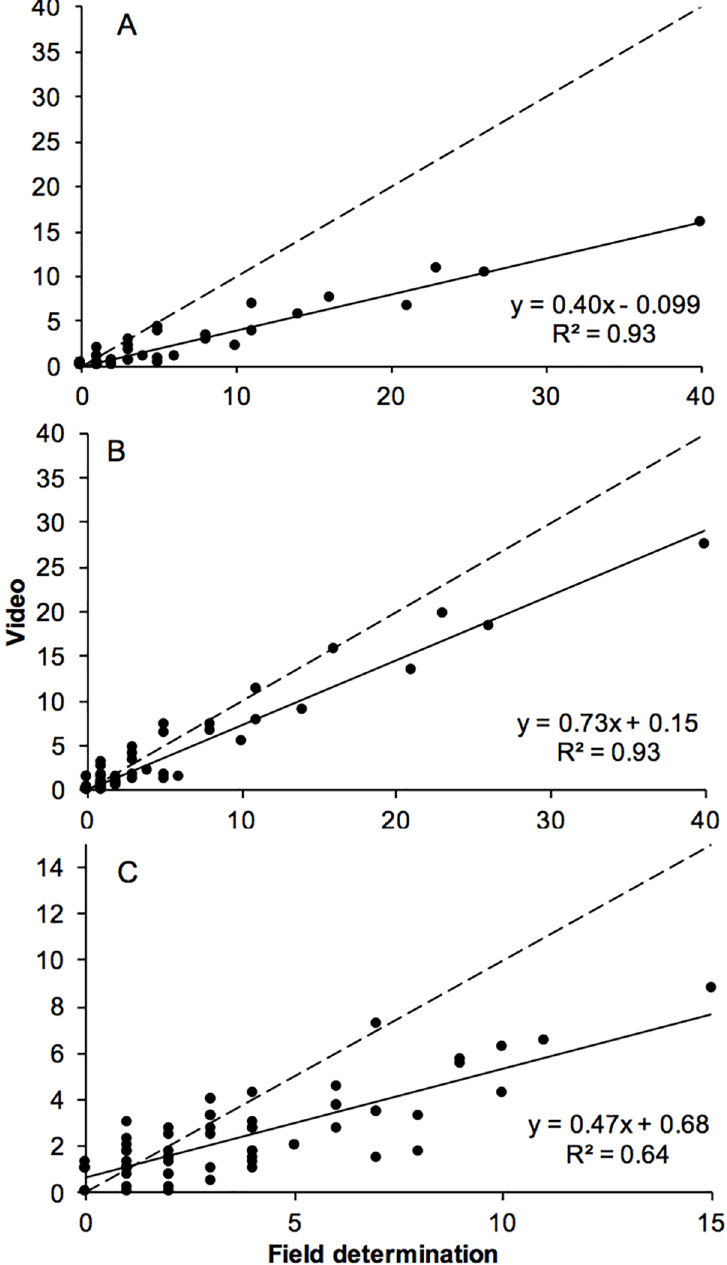
Fig 5. Correlations between field and video observations. The correlationbetweenthe abundance of living oysters determinedin the field and the abundanceof (A) “probablyliving” oysters, (B) the sum of “probablyliving” and “possiblyliving” oysters estimated by video. (C) shows the corresponding correlationfor dead oysters. (# Ostrea edulis per 4 m sequence). Video-estimates represent averagesfrom two